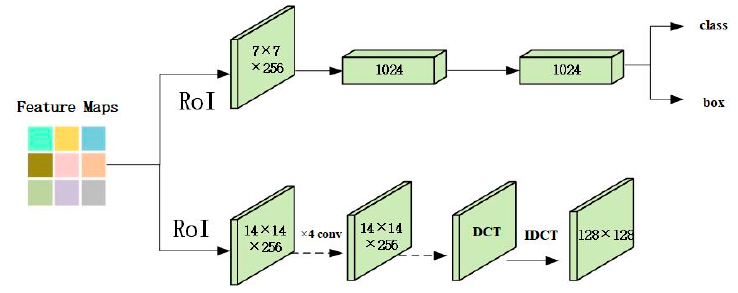
Figure 5. DCT network.